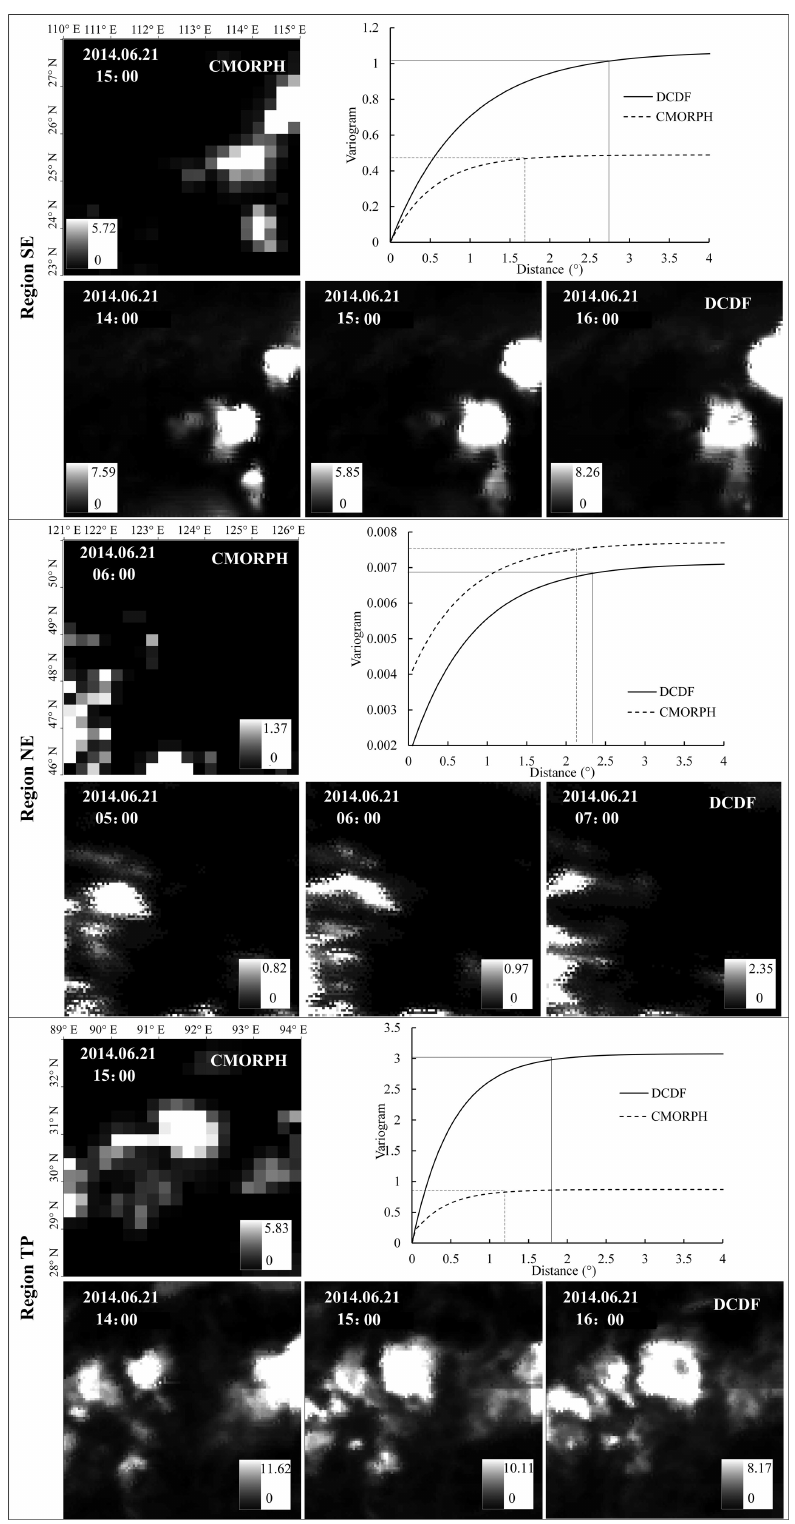
Figure 5. CMORPH precipitation estimates at a nominal resolution of 0.25 ◦ and DCDF precipitation maps at a 0.05 ◦ resolution for regions SE, NE and